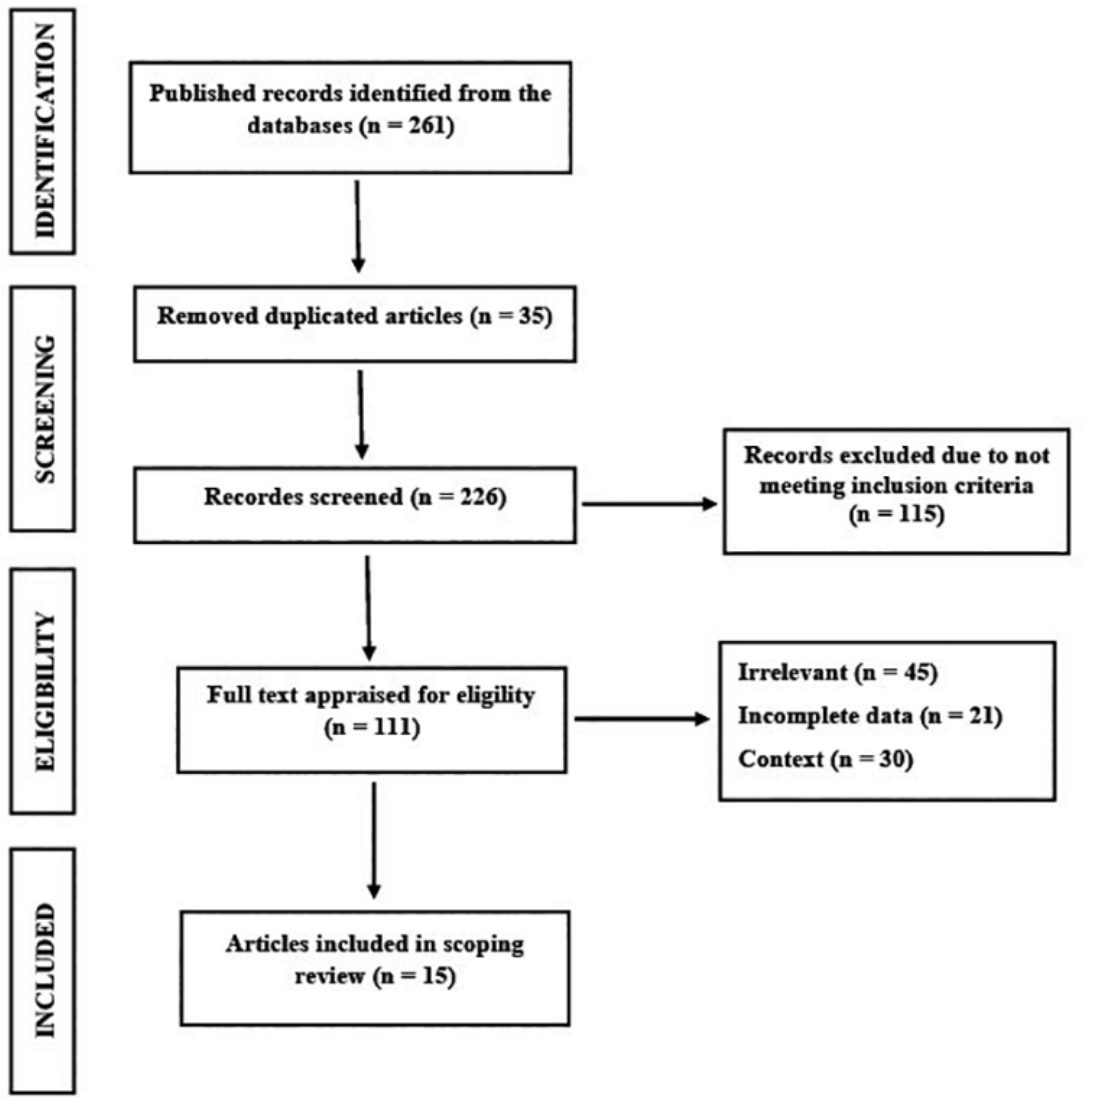
Figure 1. PRISMA flowchart showing the study design